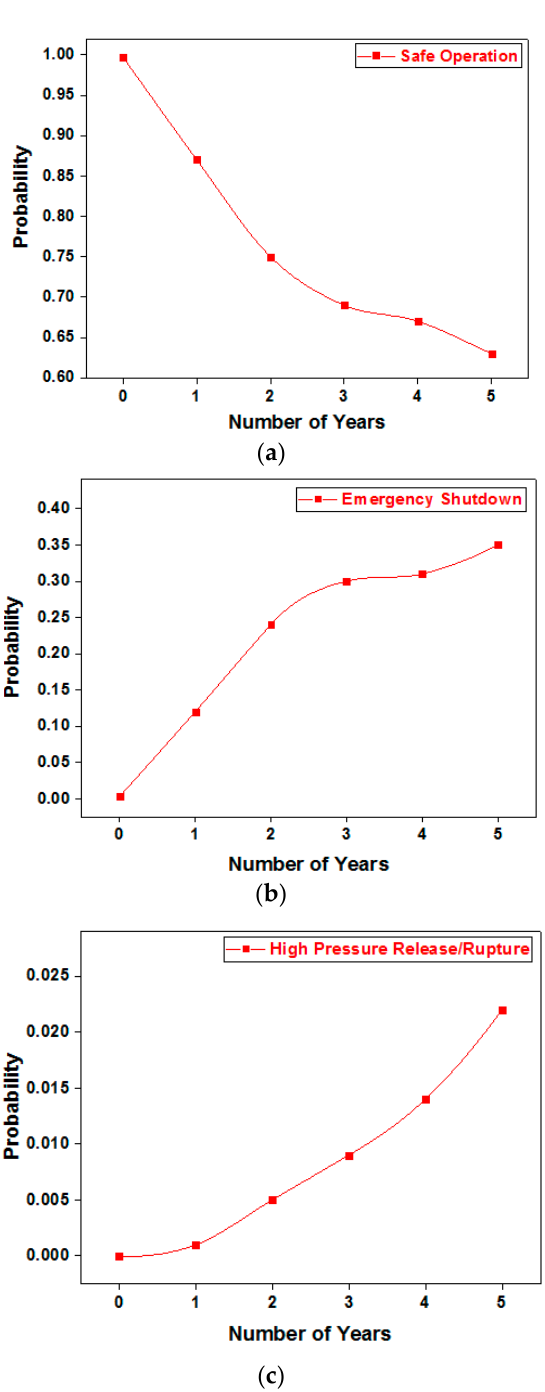
Figure 5. Updated probabilities of different end-states P j , t from year 0 to 5. ( a ) Safe operation. ( b ) Process shutdown. ( c ) High-pressure release /